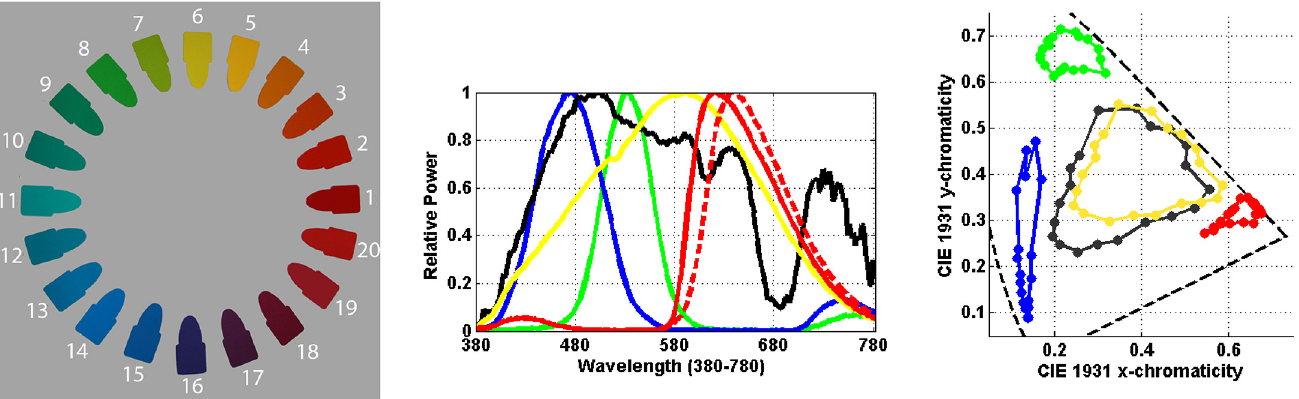
Fig 2. (Left) Photograph giving a general indication of the colours of the 20 chromatic stimulus papers used in Logvinenko & Tokunaga ’ s experiment. To evaluate the colours correctly requires viewing the actual Munsell papers. Their Munsell notations starting from 1 are: 10RP 5/14, 5R 4/14, 10R 5/16, 5YR 7/ 14, 10YR 7/14, 5Y 8/14, 10Y 8.5/12, 5GY 7/12, 10GY 6/12, 5G 5/10, 10G 5/10, 5BG 6/10, 10BG 5/10, 5B 5/10, 10B 5/12, 5PB 5/12, 10PB 4/12, 5P 4/12, 10P 4/12, 5RP 5/12. (Centre) Spectral power distribution of the illuminants employed in Logvinenko & Tokunaga ’ s experiment. The line colour indicates the colour of the light each line represents. The R2 light is represented by the dashed red line and the neutral light by the black line. (Right) The dots indicate the CIE 1931 chromaticity coordinates of the light reflected from the 20 stimulus papers under all the lights except R2. The marker colour indicates the colour of the corresponding